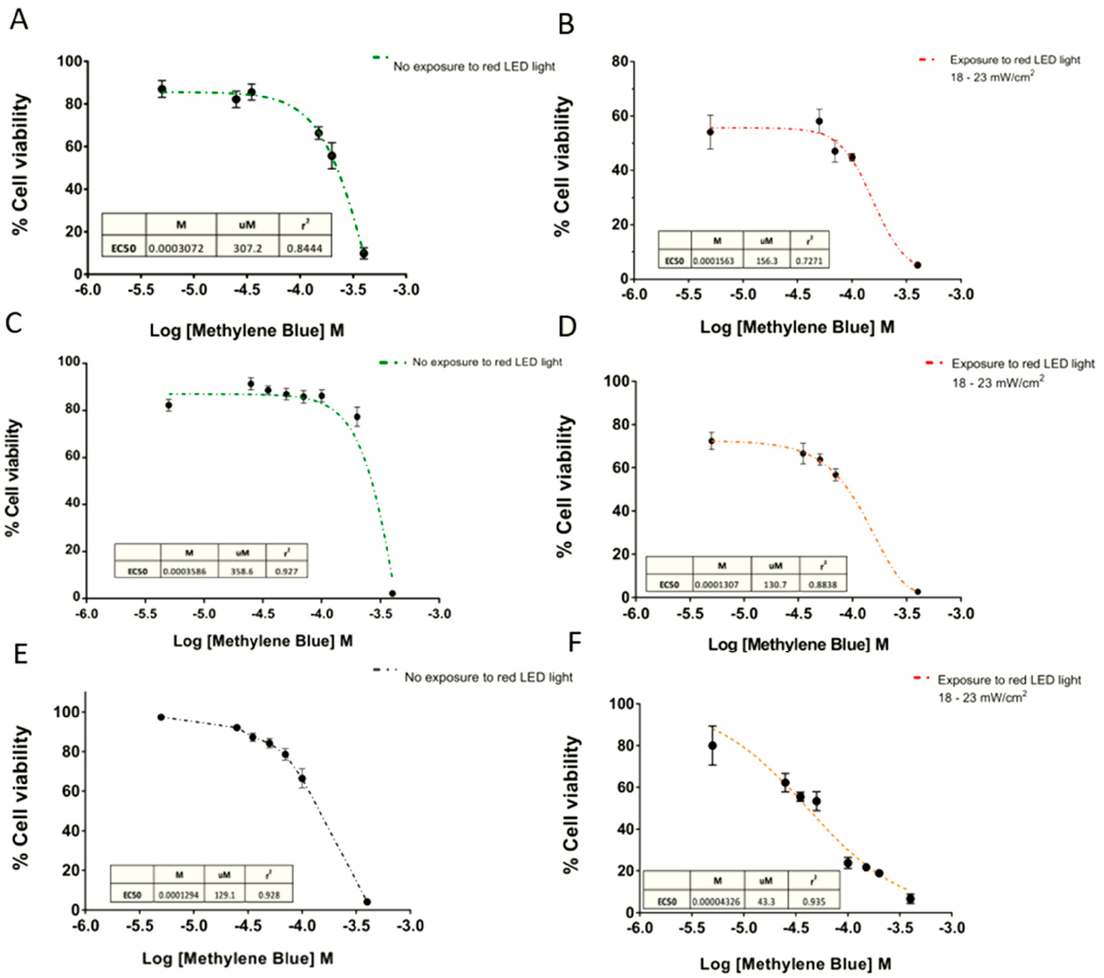
Figure 5. Dose-response curves of Methylene Blue. Dose-response curves in ( A and B ) SHSY5Y human neuroblastoma, ( C and D ) U87 glioblastoma, and ( E and F ) GL261 cell lines. The concentration of MB produced a 50% response of the maximal response (EC 50 ) calculated in absence of light, and after 6 min exposure at 18–23 mW/cm 2 . Data are expressed as mean ± SEM. The data were normalized as a function of the mean negative control treatment (CN = cells without MB).